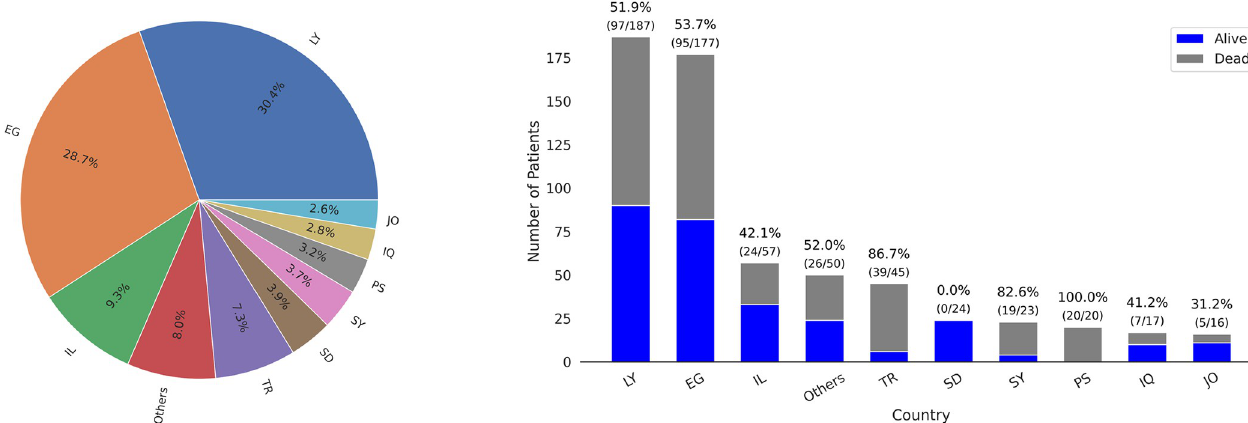
Fig 4. Distribution of patients admitted to non-European ICUs as a percentage of the overall non-European cohort (left panel). Number of patients admitted to non-European ICUs as well as the mortality rate per non-European country, shown as a ratio between survivors (blue) and non-survivors (grey) (right panel). Country and territory abbreviations are detailed in S9